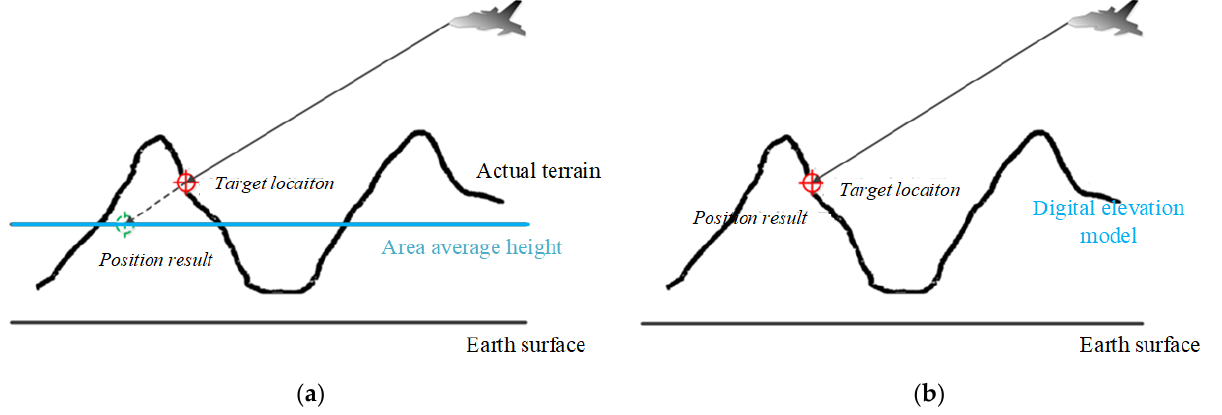
Figure 7. Schematic diagram of target positioning results in areas with complex terrain. ( a ) Positioning results using the earth ellipsoid model; ( b ) Positioning results using DEM model.